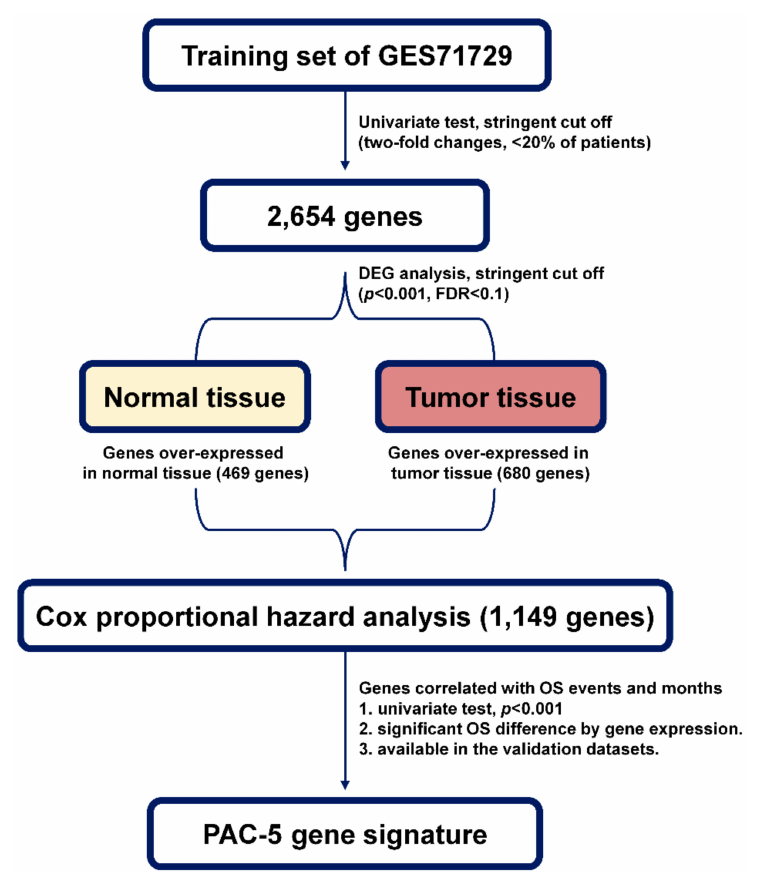
Figure 1. Schematic overview of the strategy used for prognostic model